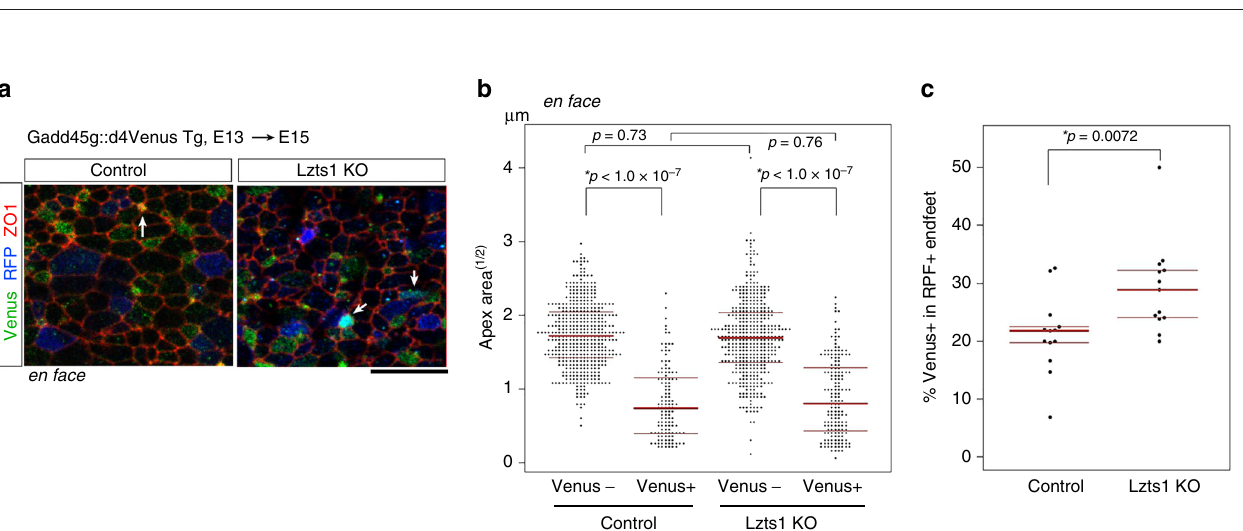
Fig. 3 Loss-of-function of Lzts1 retards radial migration through differentiation. a – d Lzts1-siRNA#1 or a negative control siRNA (siRNA-NC) was in vivo electroporated at E13, and sections of the E14 c or E15 a , b , d brain were examined using IHC with anti-Pax6 a , anti-BrdU (30-min BrdU pulse labeling) b , anti-Tbr2 c , anti-Ki67 and anti-BrdU d antibodies. The mitotic index (MI) d indicates the percentage of Ki67 + cells among BrdU + GFP + cells that received BrdU 20h before fi xation. Means±s.d., a N = 9, 9; b N = 10, 9; d N = 8, 6; d N = 9, nine sections from three embryos per experiment, Wilcoxon rank sum test. e and f CRISPR/ Cas9-induced disruption (KO) of lzts1 successfully reduces Lzts1 expression. The hCas9 and guide RNA for lzts1 were co-expressed with EGFP by performing in